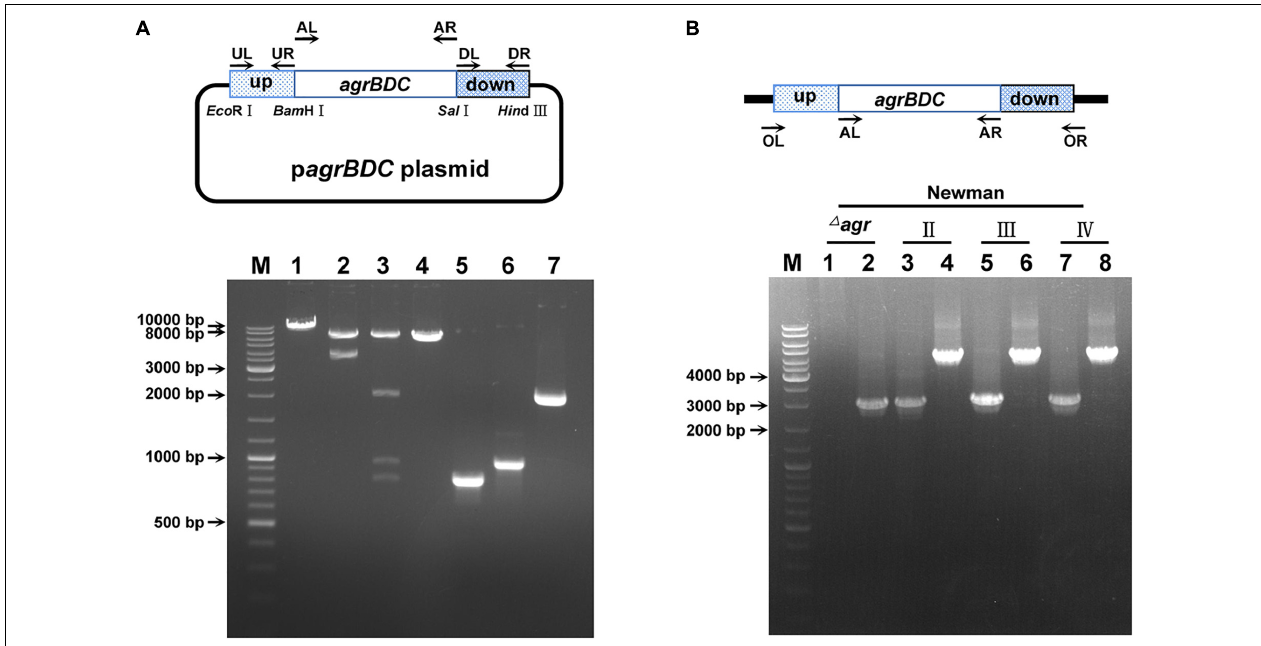
FIGURE 1 | The identification of agr allelic mutant in S. aureus Newman. (A) The confirmation of agr allele replacement plasmid by restriction enzyme digestion (take type II agrBDC replacement as an example). Bands 1, 2, and 3 are the single ( Bam HI), double ( Eco RI + Hin dIII), and four ( Bam HI, Eco RI, Hin dIII, and Sal I) enzymes digestion patterns of agrBDC- II allelic replacement plasmid, respectively. Band 4 is the pattern of empty pBT2 plasmid linearized by Bam HI. Bands 5, 6, and 7 are patterns of the PCR amplification products of agrBDC -up (Band5, primers UL + UR), agrBDC -down (Band6, primers DL + DR), and agrBDC -II from N315 (Band7, primers AL + AR) fragments, respectively. (B) The confirmation of agr allelic replacement strains in Newman background by PCR amplification with primers AL + AR (Bands 1, 3, 5, 7) and primers OL + OR (Bands 2, 4, 6, 8). Bands 1–2 refer to the PCR products of Newman (cid:49) agrBDC mutants, Bands 3–4 are the PCR products of the congenic strain harbor agrBDC -II sequence, bands 5–6 refer to PCR products of the congenic strain with agrBDC -III replacement, and bands 7–8 for agrBDC -IV replacement. All primers are shown in Supplementary Table 2